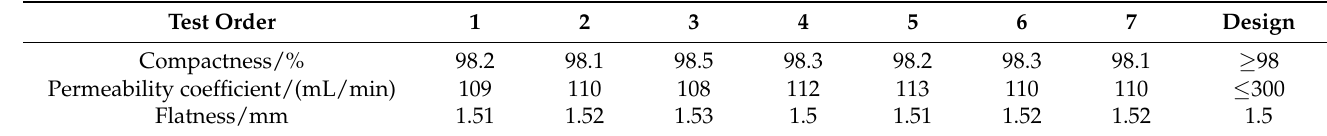
Table 16. On-site inspection results of salt-storage